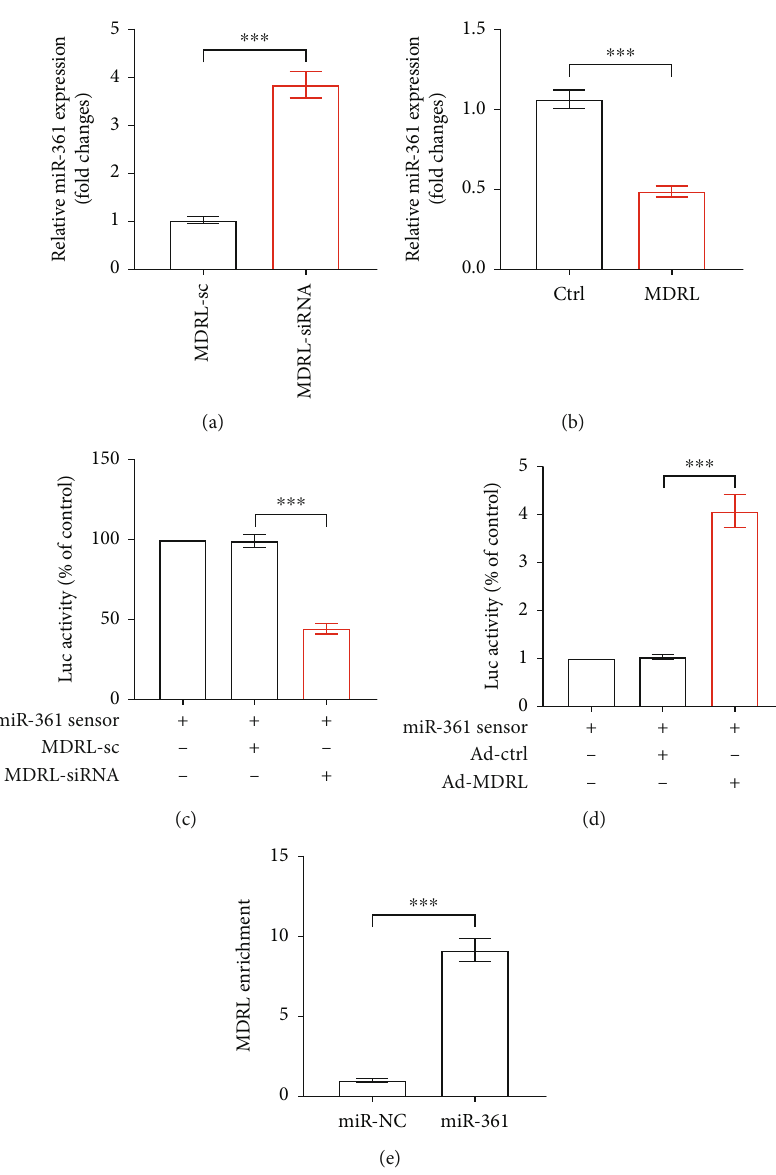
Figure 5: MDRL acts as an endogenous sponge to miR-361. (a) The expression levels of miR-361 in MSMCs transfected with siRNA (MDRL-siRNA) or scramble (MDRL-sc) were analyzed by qRT-PCR. (b) The expression levels of miR-361 in MSMCs transfected with adenoviral MDRL (MDRL) or control adenovirus (ctrl) were analyzed by qRT-PCR. (c) Luciferase activities were measured in HEK- 293T cells transfected miR-361 sensor luciferase reporter vector, along with MDRL-siRNA or MDRL-sc. (d) Luciferase activities were measured in HEK-293T cells transfected miR-361 sensor luciferase reporter vector, along with ctrl or MDRL. (e) MDRL binds to miR- 361. Biotin-conjugated pulldown assay and qRT-PCR were performed in MSMCs. Data are presented as mean ± SEM. ∗∗ P < 0 : 001 vs MDRL-sc or ctrl or miR-361 sensor